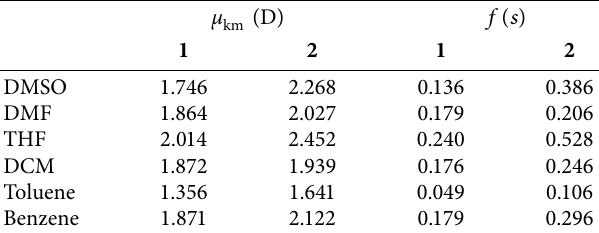
Table 2: Transition dipole moment and oscillator strength for complexes 1 and 2